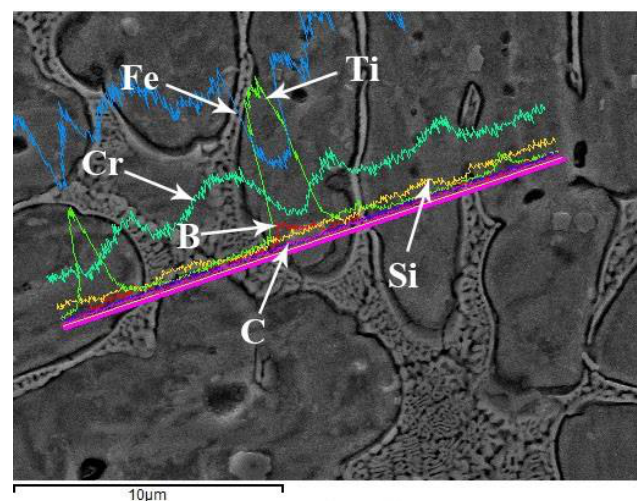
Figure 12. Elemental distributions of irregular cubic blocks in Figure 8b.